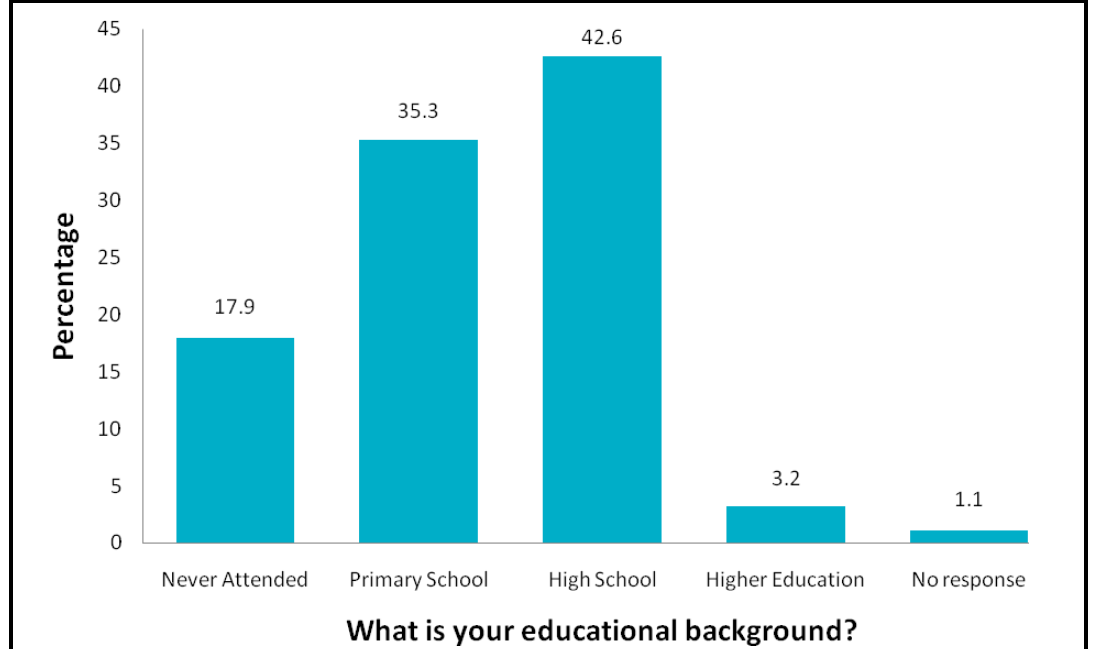
Figure 6. Marital status of respondents.